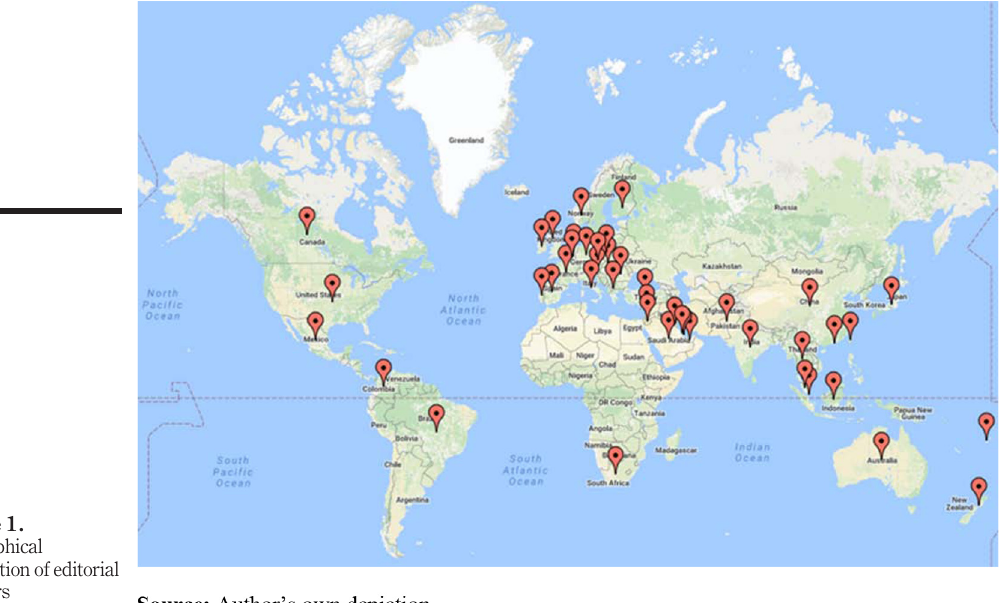
Figure 1. Geographical distribution ofeditorial